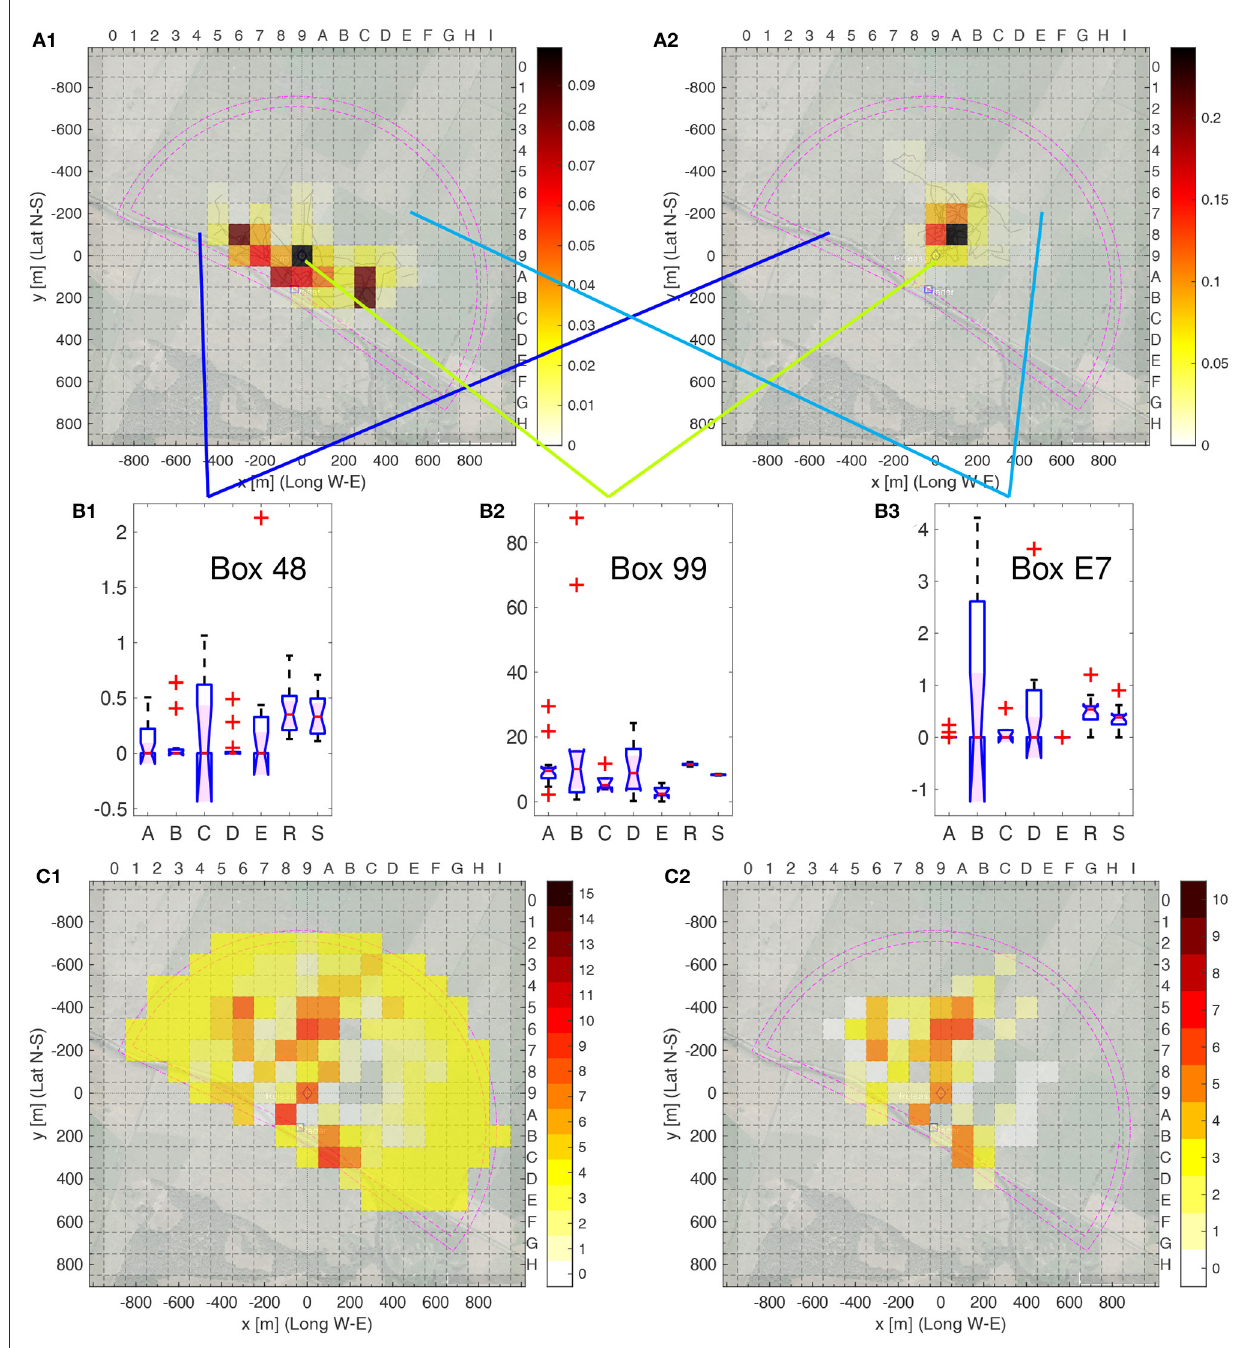
FIGURE5 Heatmap analysis of individual bees. (A1, A2) Heat map examples. (A1) Bee A01, bee number 1 from area A; (A2) Bee R01, bee number 1 from model R. The respective flight trajectories are given in pale lines. The relative number per box of fixes of the smoothed trajectories is color coded as indicated in the color bar to the right; the sum over all boxes is one. The inner purple lines indicate the area covered by the radar, the outer ones cover an extra distance of 50m from the radar, which corresponds to the size of the smoothing filter. (B1–B3) Boxplots of the relative frequencies of fixes of each bee being in one of the three selected boxes of the total of 342 boxes as indicated by the blue, green and cyan lines. (B1) Box 48, (B2) Box 99, and (B3) E7. (C1, C2) Number of group pairs with ∆ mes 0.3, i.e., significance level **. (C1) All pairs of bee groups A to E plus R, i.e., 15 in ≥ total; (C1) all pairs of bee groups A to E only, i.e., 10 in total. The colorbars to the right gives the color code for the number of pairs. Significance levels: ** ∆ mes ≥